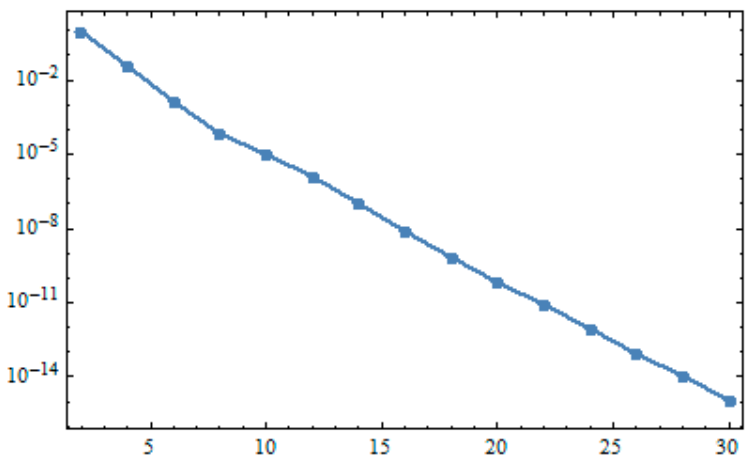
Figure 8. Error decay for the 10th-order approximation.